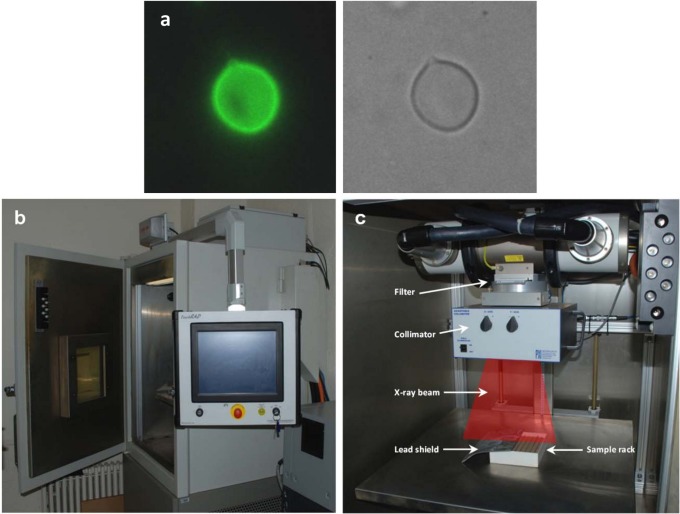
Fungal model system and experimental setup.(a) Melanized cell of the fungus C. neoformans: immunofluorescent image shows the melanin layer contiguous with the cell wall (left panel) and light microscopy image of the same cell (right panel). (b–c) External and internal views of the X-RAD 320 biological irradiator, which was used for continuous X-ray irradiation of C. neoformans cells. The cells were suspended in liquid medium in test tubes inserted into the sample rack. Radiation quality and dose rate were adjusted by varying the peak energy, current, filter, lead shielding thickness, and distance from the source.